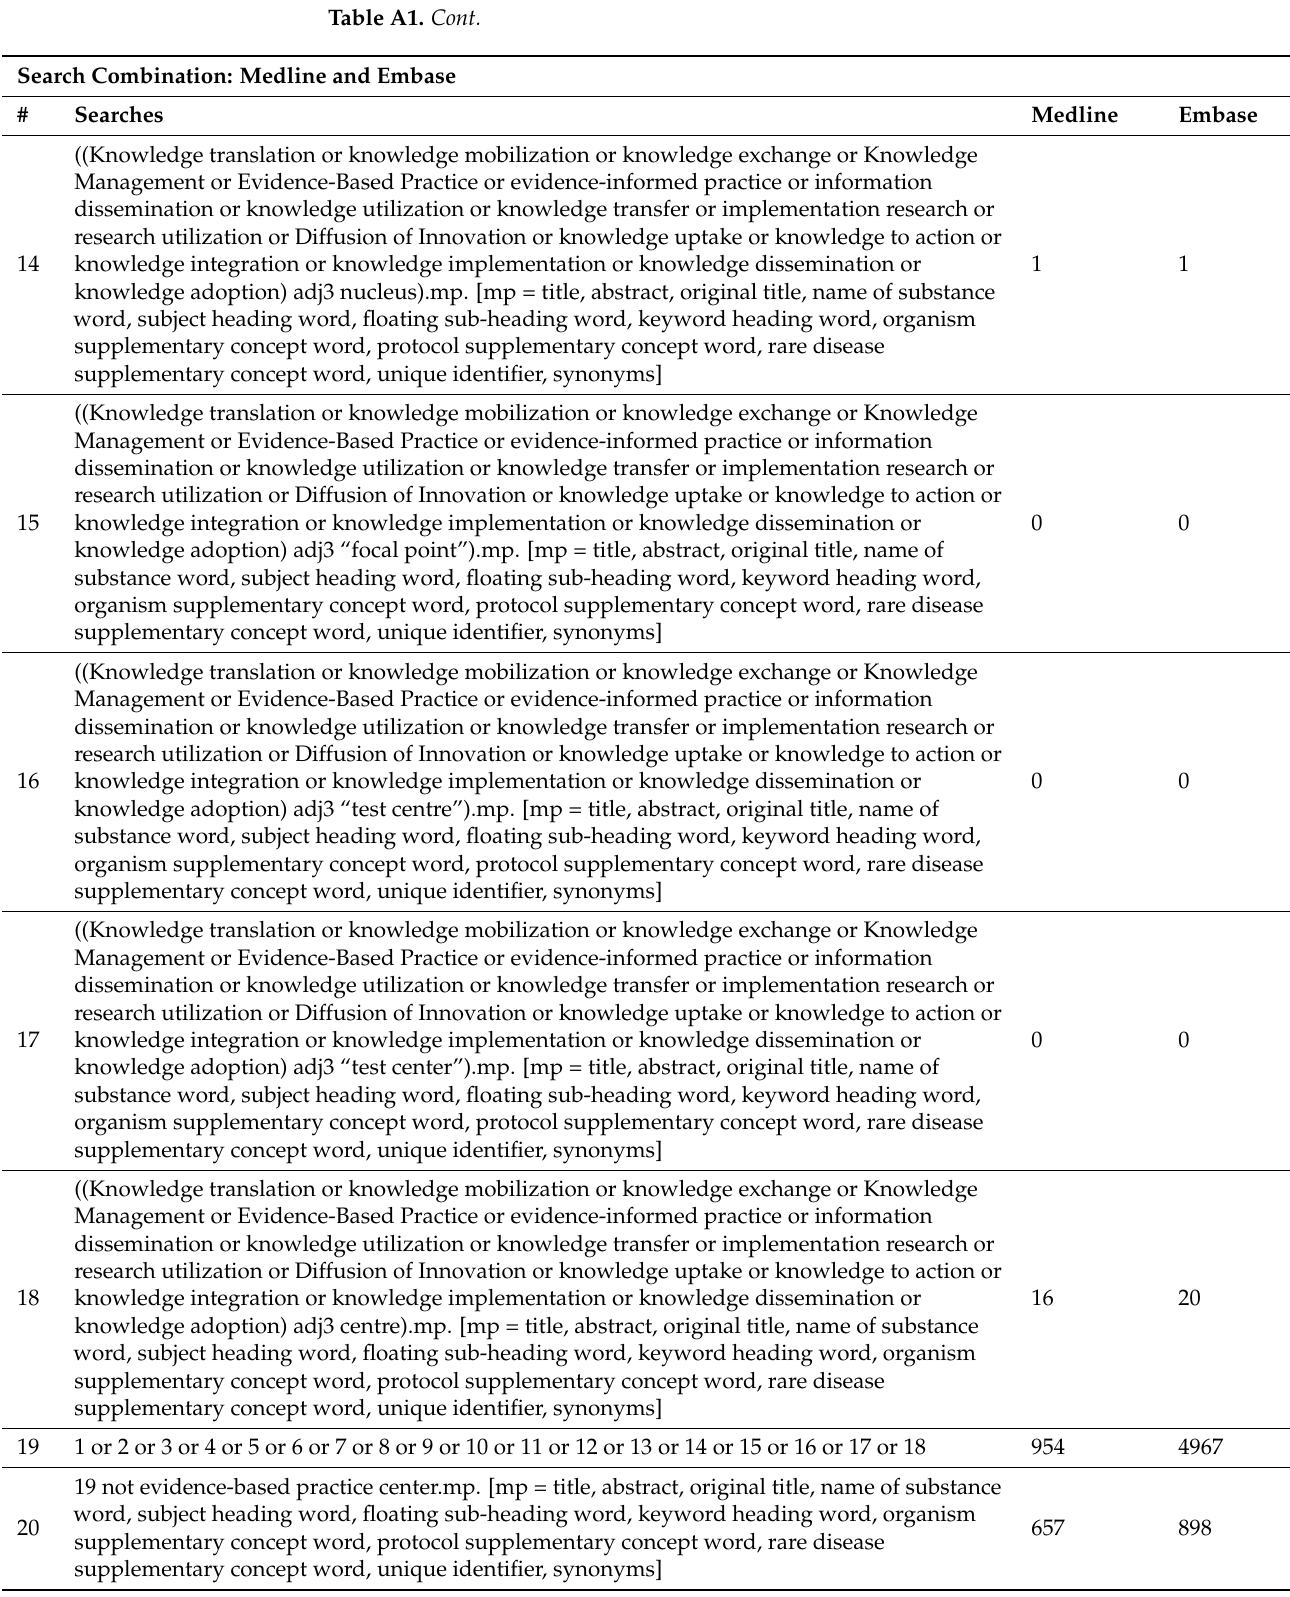
word, subject heading word, floating sub-heading word, keyword heading word, organism supplementary concept word, protocol supplementary concept word, rare disease supplementary concept word, unique identifier,